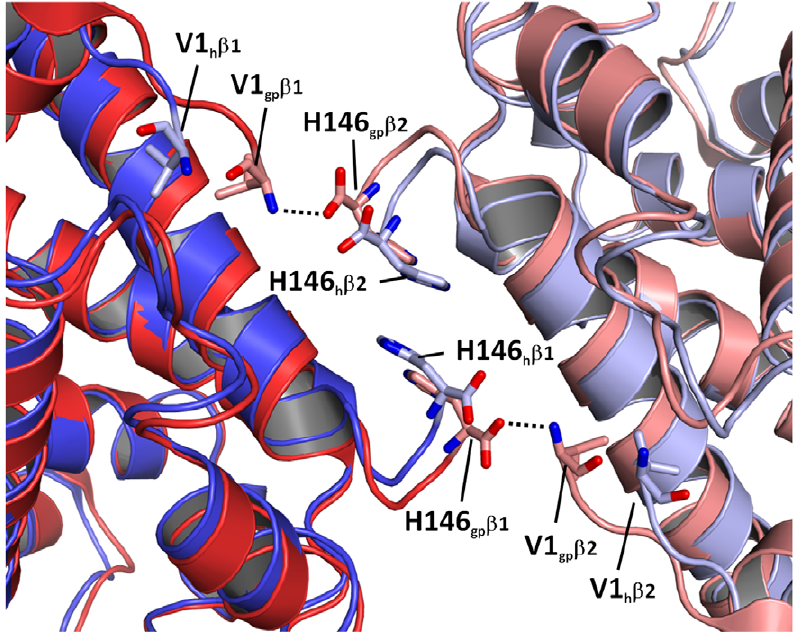
Figure 2. Stabilizing salt bridges of the b 1/ b 2 interface in guinea pig hemoglobin. The b 1/ b 2-interface of guinea pig hemoglobin in the R2- state is stabilized by two salt bridges between the N-terminal amino group of Val1 the b 1-subunit and the C-terminal carboxyl group of the b 2- subunit and vice versa. Both salt bridges are not present in the R2-state of human hemoglobin (1BBB)[10]. Guinea pig hemoglobin ( b 1=red, b 2=light red) and human hemoglobin ( b 1=blue, b 2=light blue) in the R2-state (PDB-code: 1BBB) were superimposed according to their C a -atoms. Carbon atoms of the N- and C-terminal amino acids of guinea pig hemoglobin are colored light red, while carbon atoms are colored blue in human hemoglobin. Oxygen and nitrogen atoms are colored red and blue respectively. Salt bridges are denoted by dotted lines.